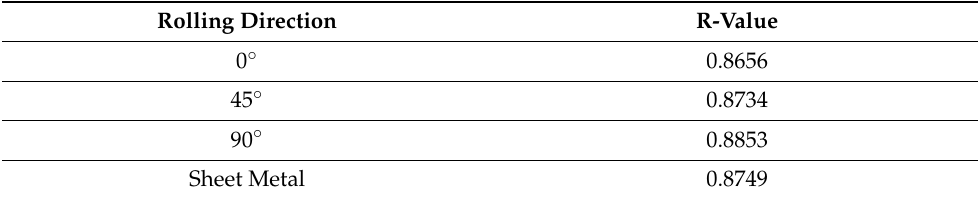
Figure 15. The R-value curve by two different measurement methods in the necking area. Table 1. R-value of DP980 in different rolling direction.